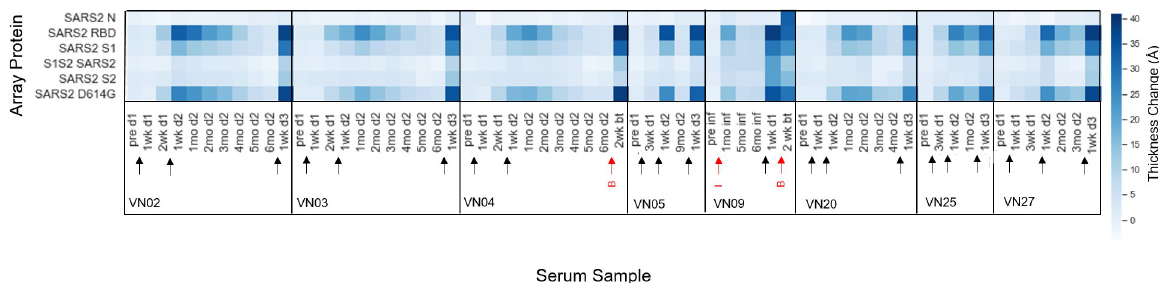
Fig 7. Heatmap of thickness change for SARS-CoV-2 proteins in COVID-19 vaccinated subject serum. Subjects received a booster shot or had a breakthrough infection. Black arrows indicate vaccine doses. Red arrows indicate infection (“I” for infection prior to vaccine, and “B” for breakthrough infection).